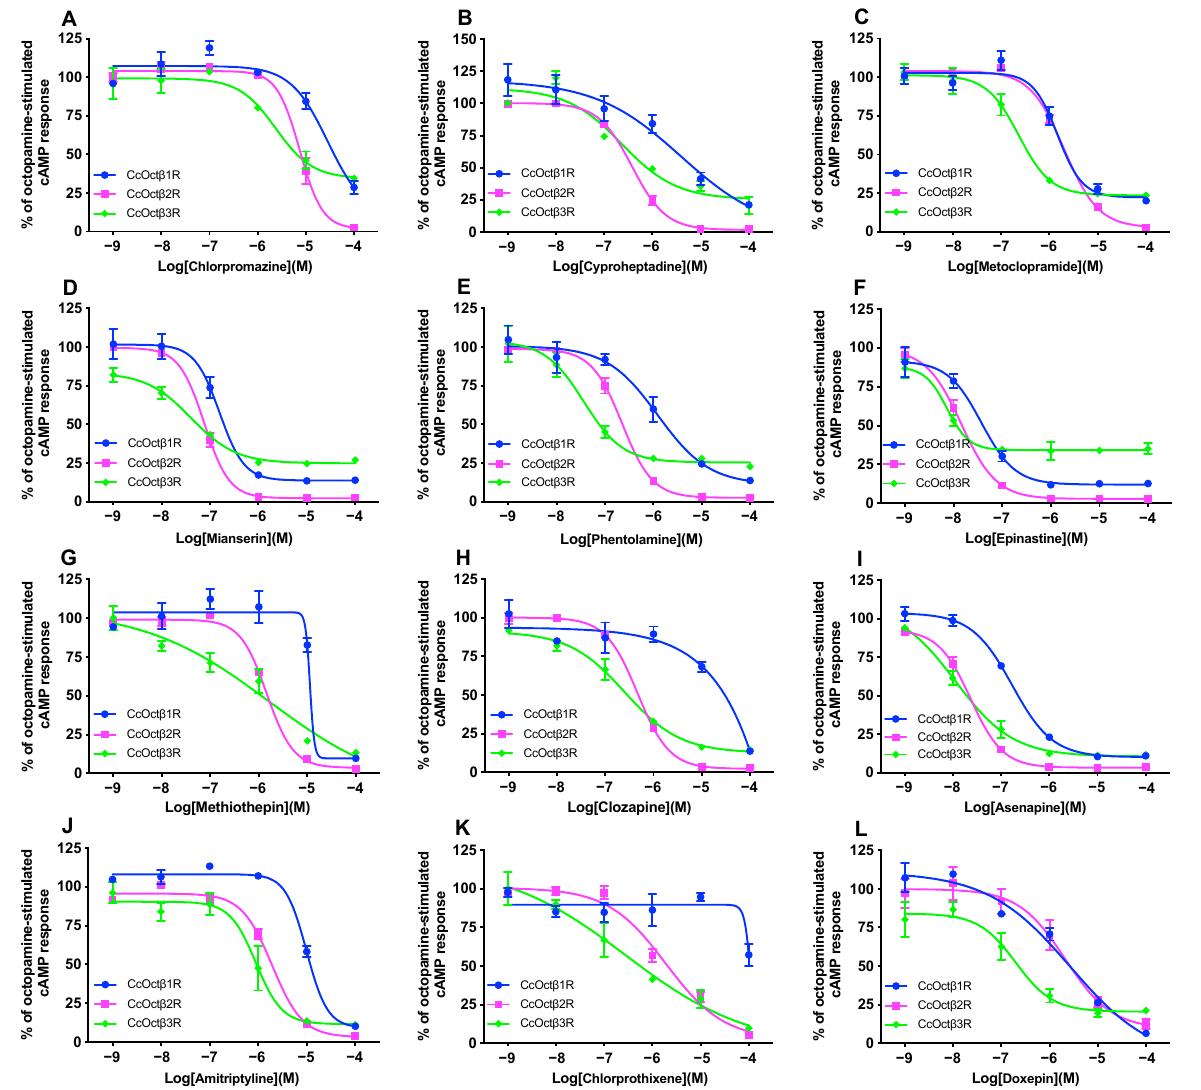
Figure 6. Dose-response curves of 12 antagonists on OA-stimulated intracellular cAMP production in CcOct β R-expressing CHO-K1 cells. Antagonists used were chlorpromazine ( A ), cyproheptadine ( B ), metoclopramide ( C ), mianserin ( D ), phentolamine ( E ), epinastine ( F ), methiothepin ( G ), clozapine ( H ), asenapine ( I ), amitriptyline ( J ), chlorprothixene ( K ), and doxepin ( L ). Each individual curve is normalized to its respective OA stimulation in the absence of antagonist (=100%). Data are presented as means ± SE of four